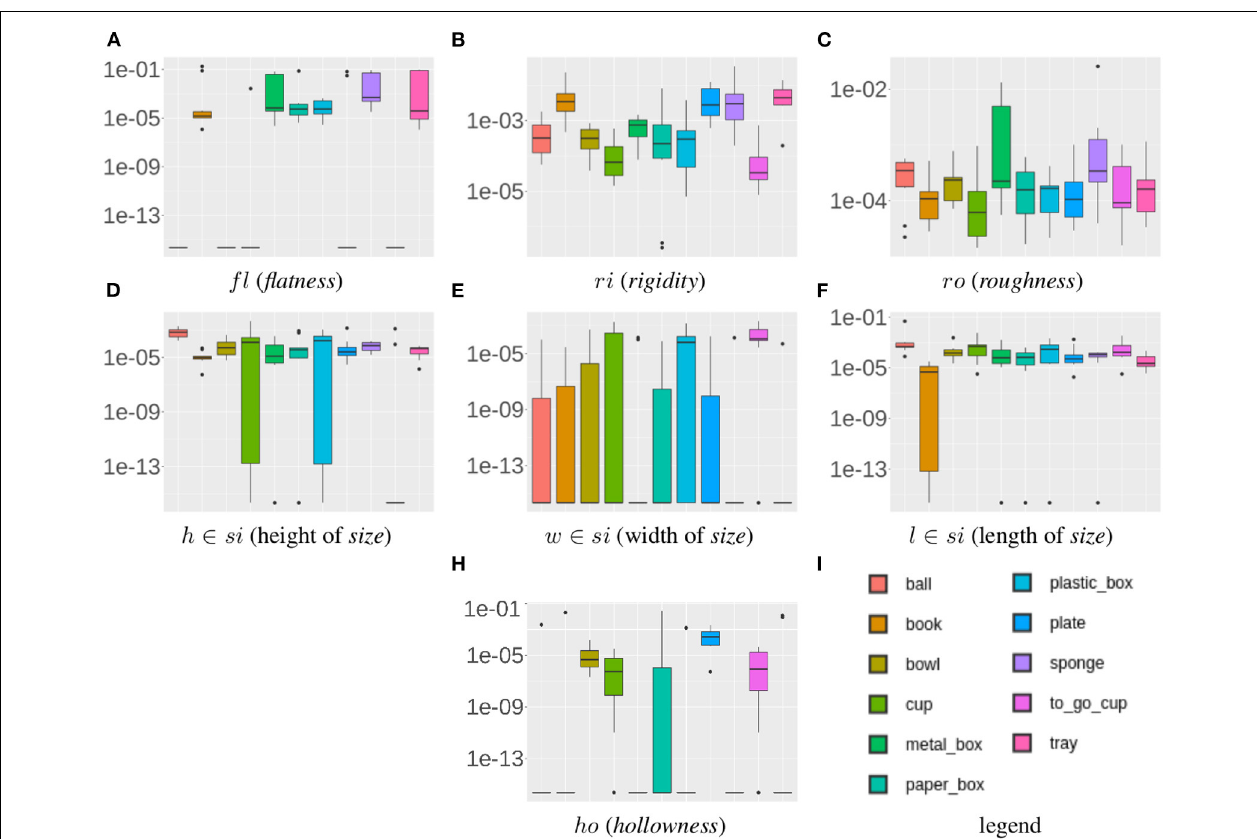
FIGURE 9 | Mean variance for physical properties [ fl , ri , ro , si , he , ho ] illustrated in form of a Box plot (in log-scale to provide insights of respective intra property variances compared to linear-scale shown in Table 2 ). Note that, in order to be able to display all variances (including zero) in log-scale, we add an epsilon on each value before computing log. Heaviness is excluded as all variance values are zero for this property due to the resolution of the scale.